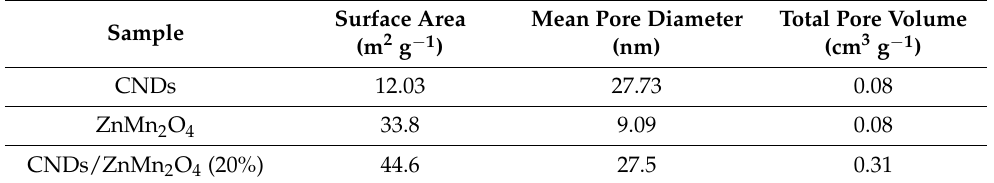
Table 1. Textural properties of the CNDs, ZnMn 2 O 4 , and CNDs/ZnMn 2 O 4 (20%) photocatalysts.